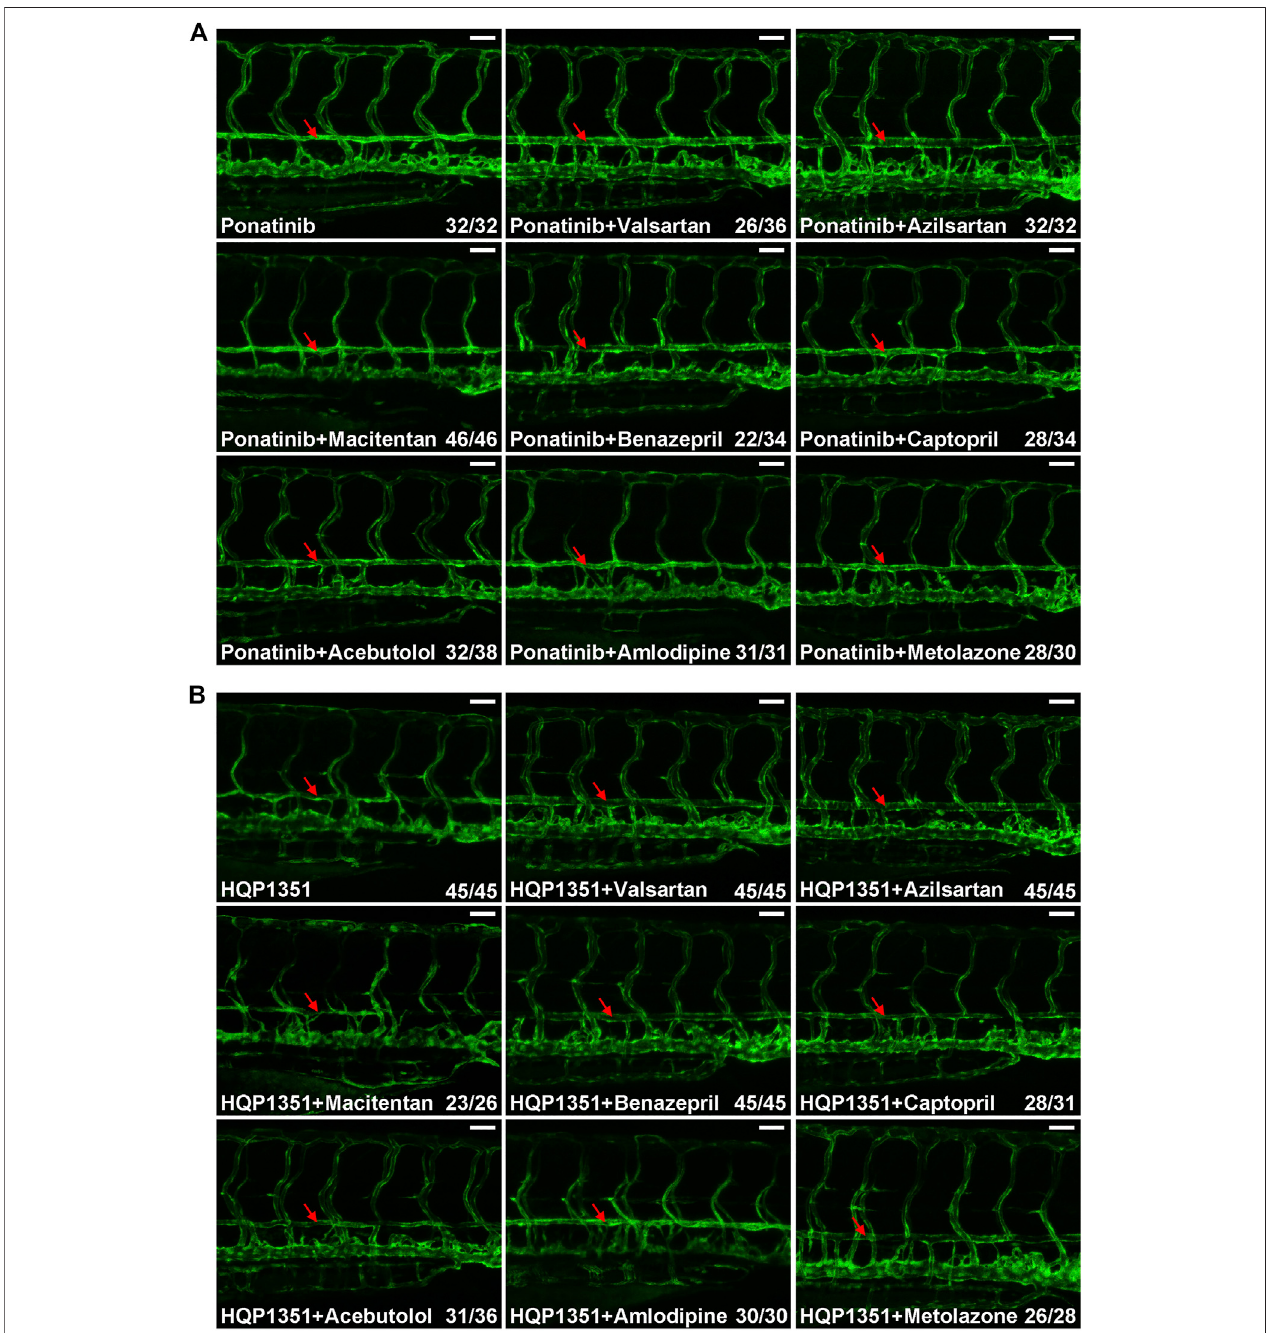
FIGURE4| Effectsofanti-hypertensivedrugsonponatiniborHQP1351induceddorsalaortaconstriction. (A) Embryoswereco-treatedwiththeindicatedcompoundsfrom 2 to4dpf andanalyzedasin Figure 1B . Valsartan and azilsartan areARBs and abletorescueponatinib-induced dorsalaortaconstriction.Other anti-hypertensivedrugsare less ef fi cacious to minimize ponatinib-induced vascular defects. (B) Valsartan, azilsartan, benazepril and metolazone can rescue HQP1351-induced vascular constriction while macitentan, captopril, acebutolol and amlodipine cannot. Assays were repeated and analyzed as described in Figure 1B . Red arrow: dorsal aorta. Scale bar: 50 µm.